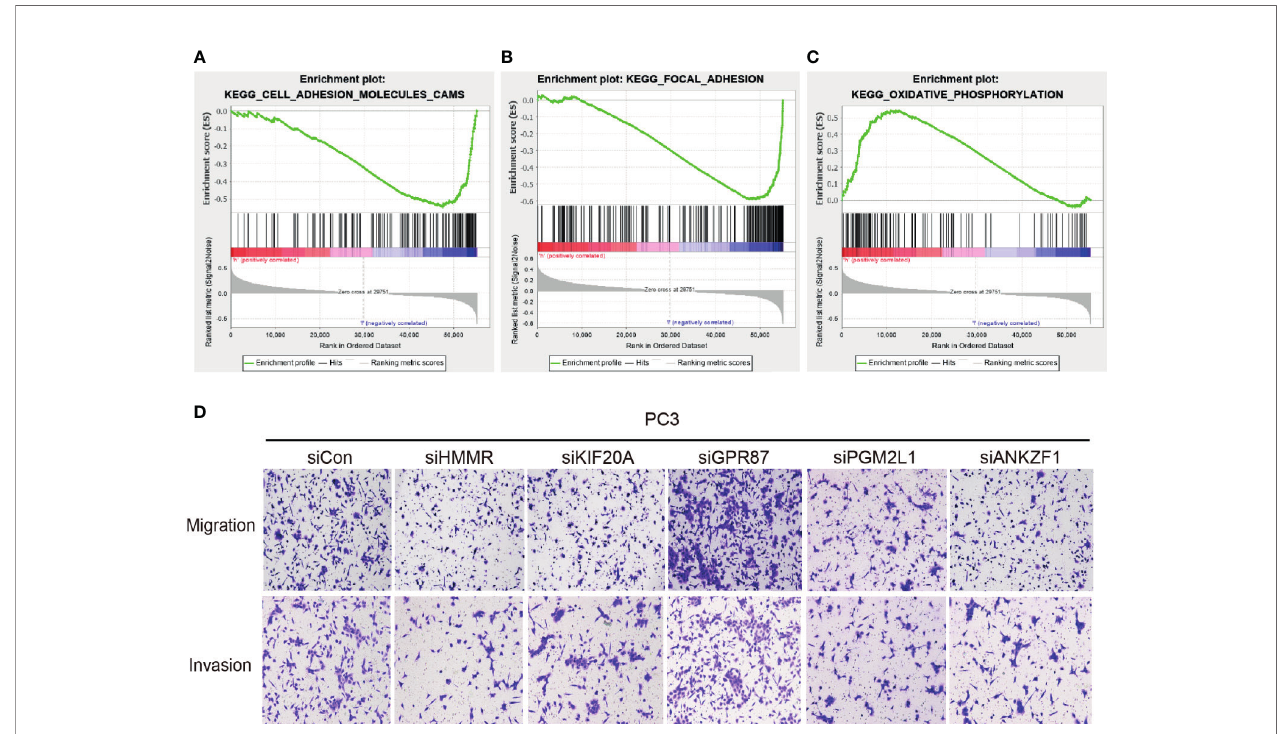
FIGURE 7 | Effect of the fi ve glycolytic genes on the migration and invasion of prostate cancer cells. (A – C) GESA analysis was performed in the high-risk group and low-risk group. (D) Investigation of ability of migration and invasion of PC3